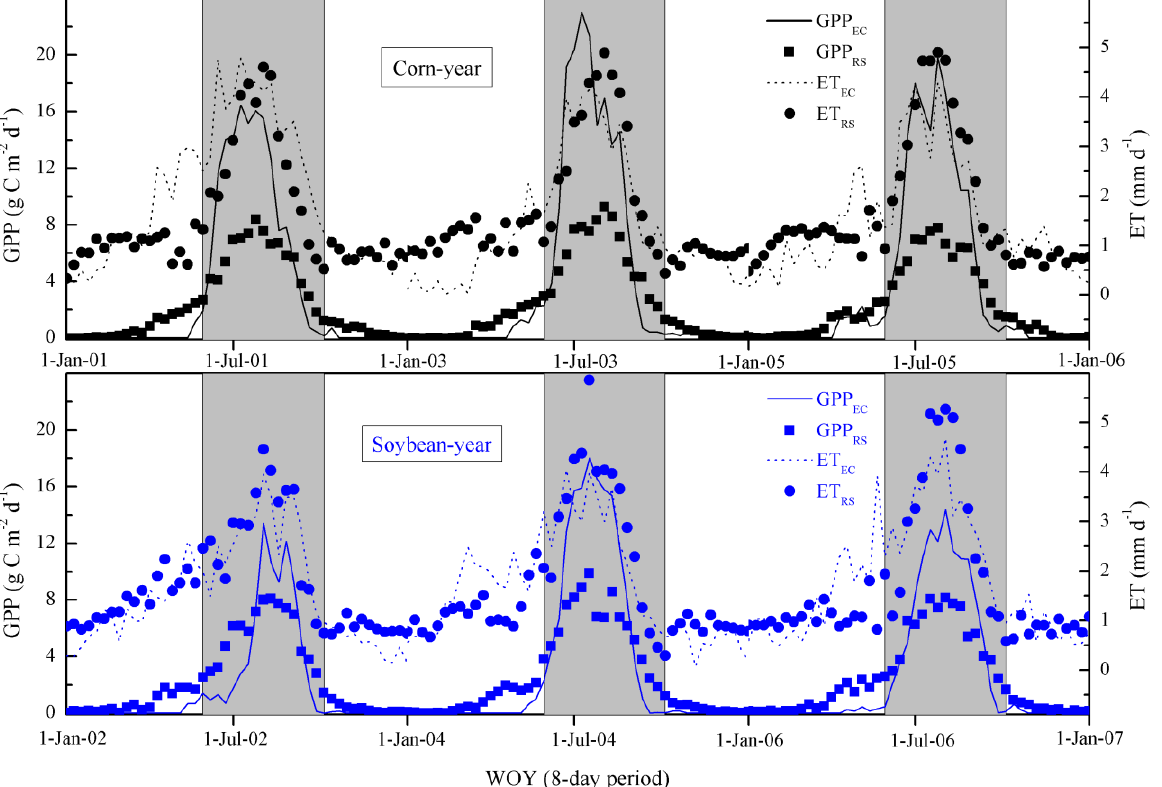
Figure 4. Comparison of seasonal dynamics in gross primary production and evapotranspiration between flux tower measurements (GPP EC , ET EC ) and MODIS estimates (GPP RS , ET RS ) at the flux tower site US-Bo1 during